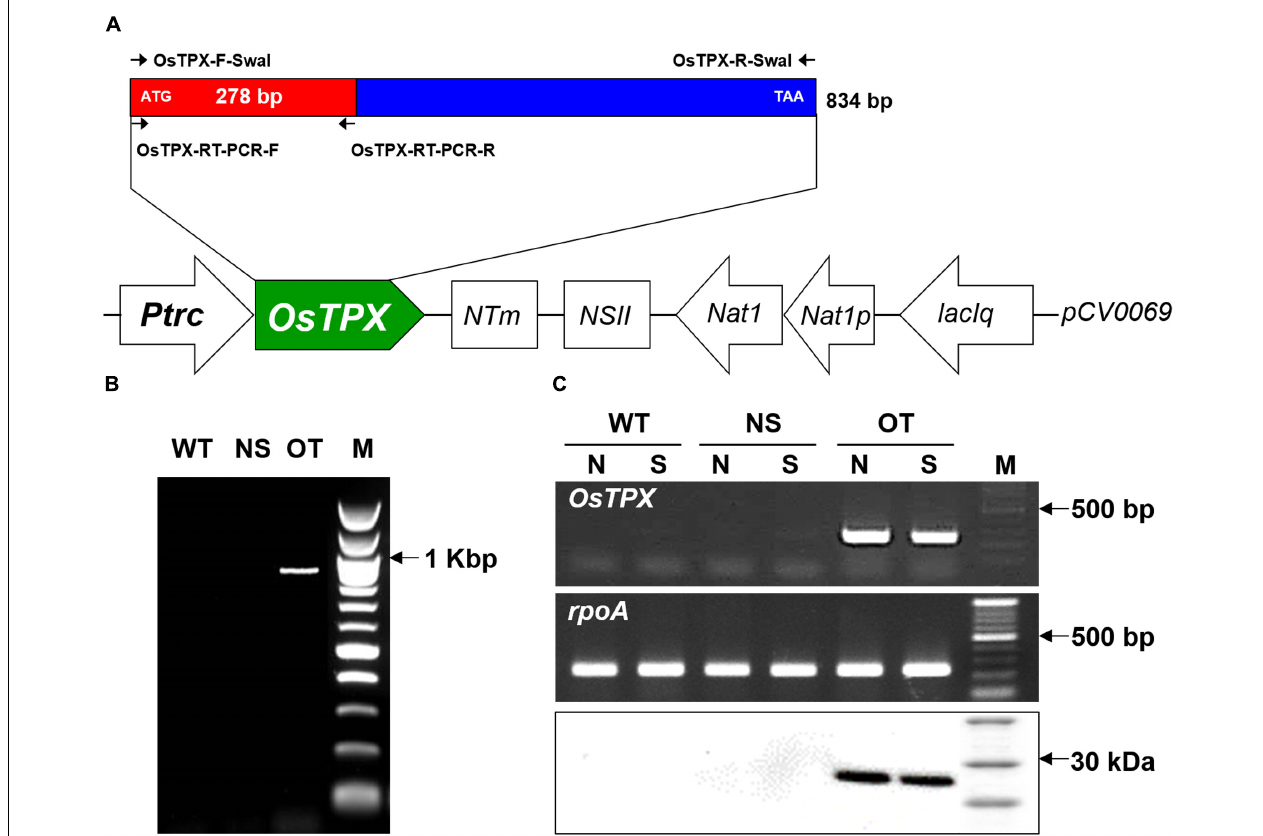
FIGURE 3 | Construct of the OT strain and confirm gene expression. (A) Schematic diagram showing the expression of OsTPX in S. elongatus . Ptrc , IPTG-inducible promoter; OsTPX , TPX gene of O. sativa ; Nat , nourseothricin antibiotic resistance; lacIq , lactose repressor. Arrows indicate direction of each gene. (B) PCR of OsTPX gene in transgenic S. elongatus (OT) to confirm genotype. (C) Expression of OsTPX gene was confirmed using semi-qRT-PCR (upper two panels) and western blotting (lower panel). The rpoA transcript was used as a control in the transcriptional analysis. N, normal condition; S, stressed